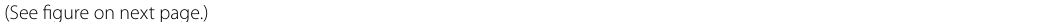
Fig. 1 Ketogenic diet decreased the hyperglycemia and ameliorated insulin resistance in diabetic mice. a Shown are the changes of body weights exerted by the different food feedings in normal and diabetic mice. b Displayed are the food intakes in different groups throughout 16 weeks of feeding. c Exhibited are the water intakes in different groups throughout 16 weeks. d Demonstrated are the total energy intakes calculated by calories in different groups throughout 16 weeks. e Unveiled are the feeding efficiencies in different groups (calculated as body weight gain (mg) per kcal food consumed). f Shown are the variations of fasting plasma glucose in different groups throughout 16 weeks. g Intraperitoneal glucose tolerance tests were performed in different groups by the end of food feeding. h Intraperitoneal insulin tolerance tests were carried out in different groups by the end of food feeding. Glucose (2 mg/g) or insulin (0.75 mU/g) was injected intraperitoneally after mice were fasted for 6–8 h. Blood glucose samples were collected at different indicated time points and measured. Areas under the curve were calculated for the quantitative analysis. i Demonstrated are the levels of plasma β-hydroxybutyric acid (β-HB) in different groups. j Insulin levels were detected in different groups by the end of food feeding. k HOMA-IR in different groups was calculated by the formula. Data were shown as mean SEM for each experiment ± performed independently 3 times (n 10–12 per group). SD (Standard diet), KD (Ketogenic diet). *P < 0.05 C57BL/6J-KD vs C57BL/6J-SD, # P < 0.05 = KK A y -KD vs KK A y -SD (ANOVA, Student–Newman–Keuls